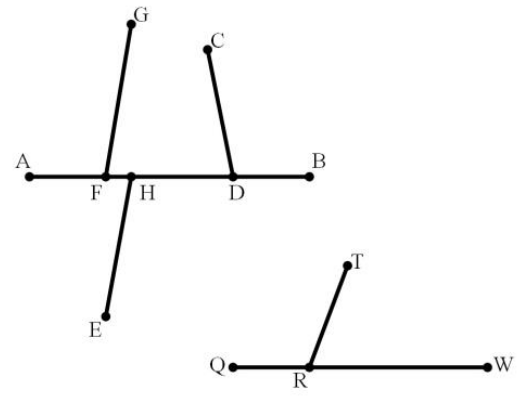
Figure 12. Identifying matching relationship for L3.